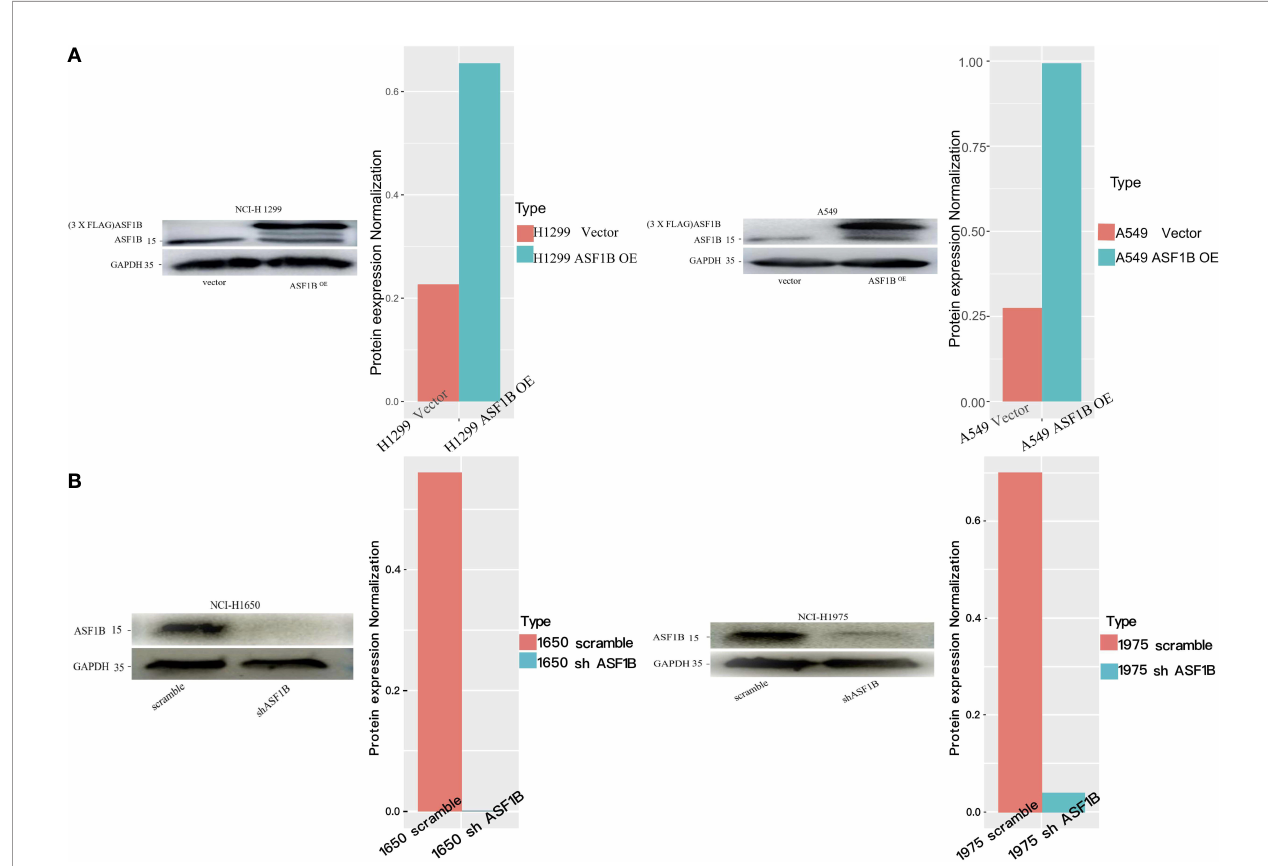
FIGURE 6 | Knockdown or overexpression of ASF1B in LUAD cell lines. (A) ASF1B protein expression in stable ASF1B-OE cells. Western blot detecting higher ASF1B protein levels in stable ASF1B-OE-H1299 or ASF1B-OE-A549 cells than those in control cells. The density levels were quanti fi ed and represented as a bar graph. (B) ASF1B protein expression in stable ASF1B-shRNA-cells. Western blot detecting lower ASF1B protein levels in stable ASF1B-shRNA-H1975 or ASF1B- shRNA-H1650 cells than those in control